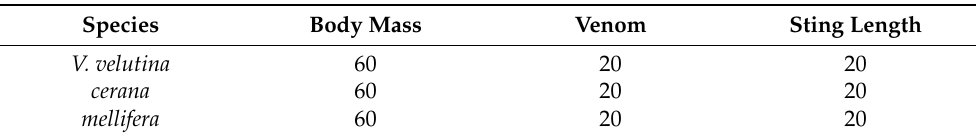
Table 2. Sample sizes for experiment 3 (in number of individuals). Data on body mass, venom mass, and sting length are shown in Figure 4. Species Body Mass Venom Sting